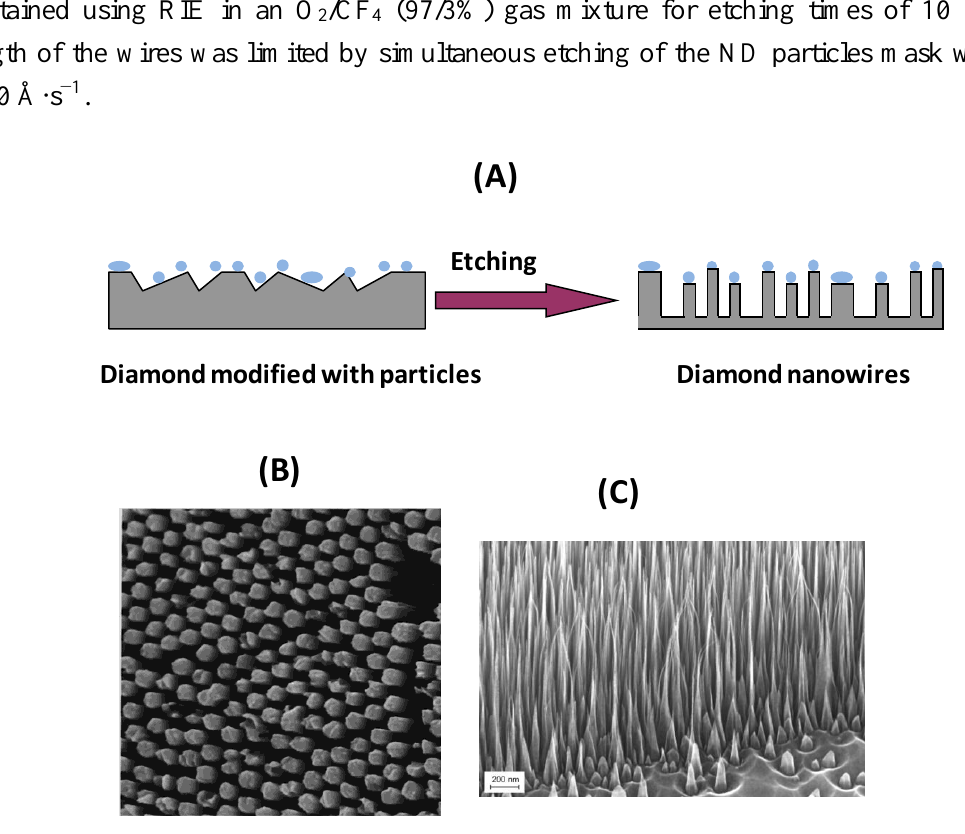
Figure 4. ( A ) Top-down etching process of CVD diamond using seed particles; ( B ) SEM image of diamond cylinders obtained using oxygen reactive ion etching (RIE) for 60 min through a 1 µM SiO 2 particle array (reprint with permission from [18]); ( C ) SEM image of vertically aligned diamond nanowires using diamond nanoparticles as masks (with courtesy of C.